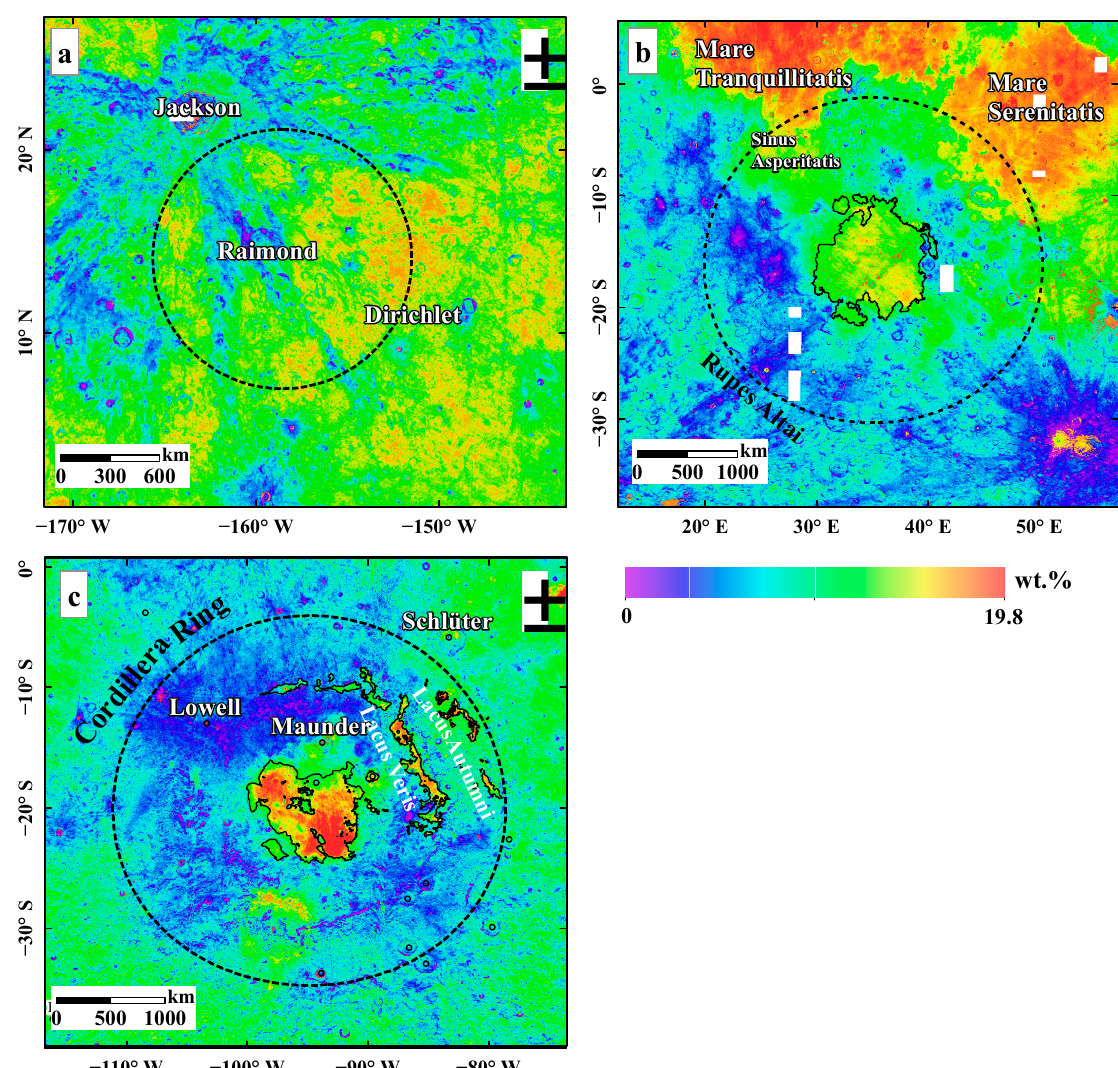
Figure 8. FeO contents of Dirichlet–Jackson Basin ( a ), Nectaris Basin ( b ), and Orientale Basin ( c ). The black lines outline Maria in the Nectaris and Orientale basins. The maps are in Mercator projection.